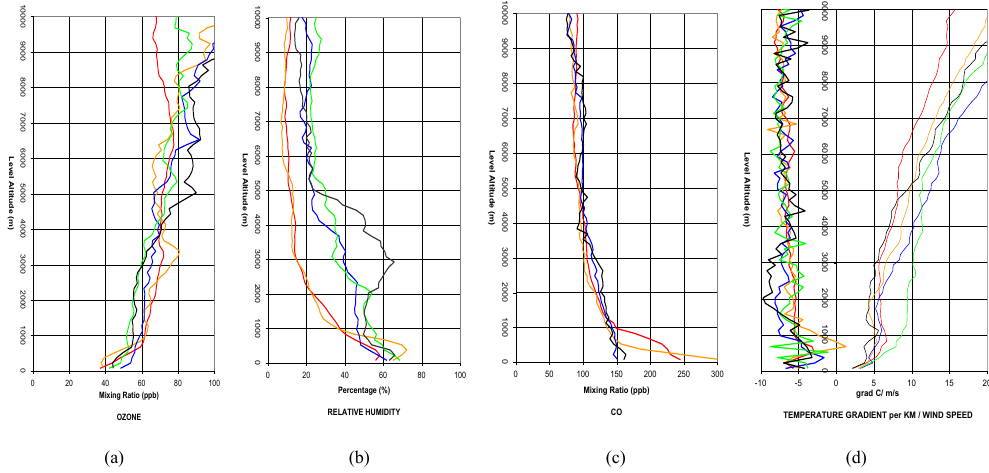
Figure 1. (a). Vertical profiles of summer (JJA) ozone over the Eastern Mediterranean airports of Cairo (red), Tel-Aviv (orange), Antalya 3 Fig. 1. (a) Vertical profiles of summer (JJA) ozone over the eastern Mediterranean airports of Cairo (red), Tel Aviv (orange), Antalya (black), (black), Heraklion (green) and Rhodes (blue), for 1994–2008, (b). Same as (a) but for relative humidity,(c). Same as (a) but for carbon 4 Heraklion (green) and Rhodes (blue), for 1994–2008; (b) same as (a) but for relative humidity; (c) same as (a) but for carbon monoxide monoxide (CO), (d). (Left), Same as (a) but for temperature gradient per km, (Right), Same as (a) but for wind speed. 5 (CO); (d) (left), same as (a) but for temperature gradient per km; (right), same as (a) but for wind speed.